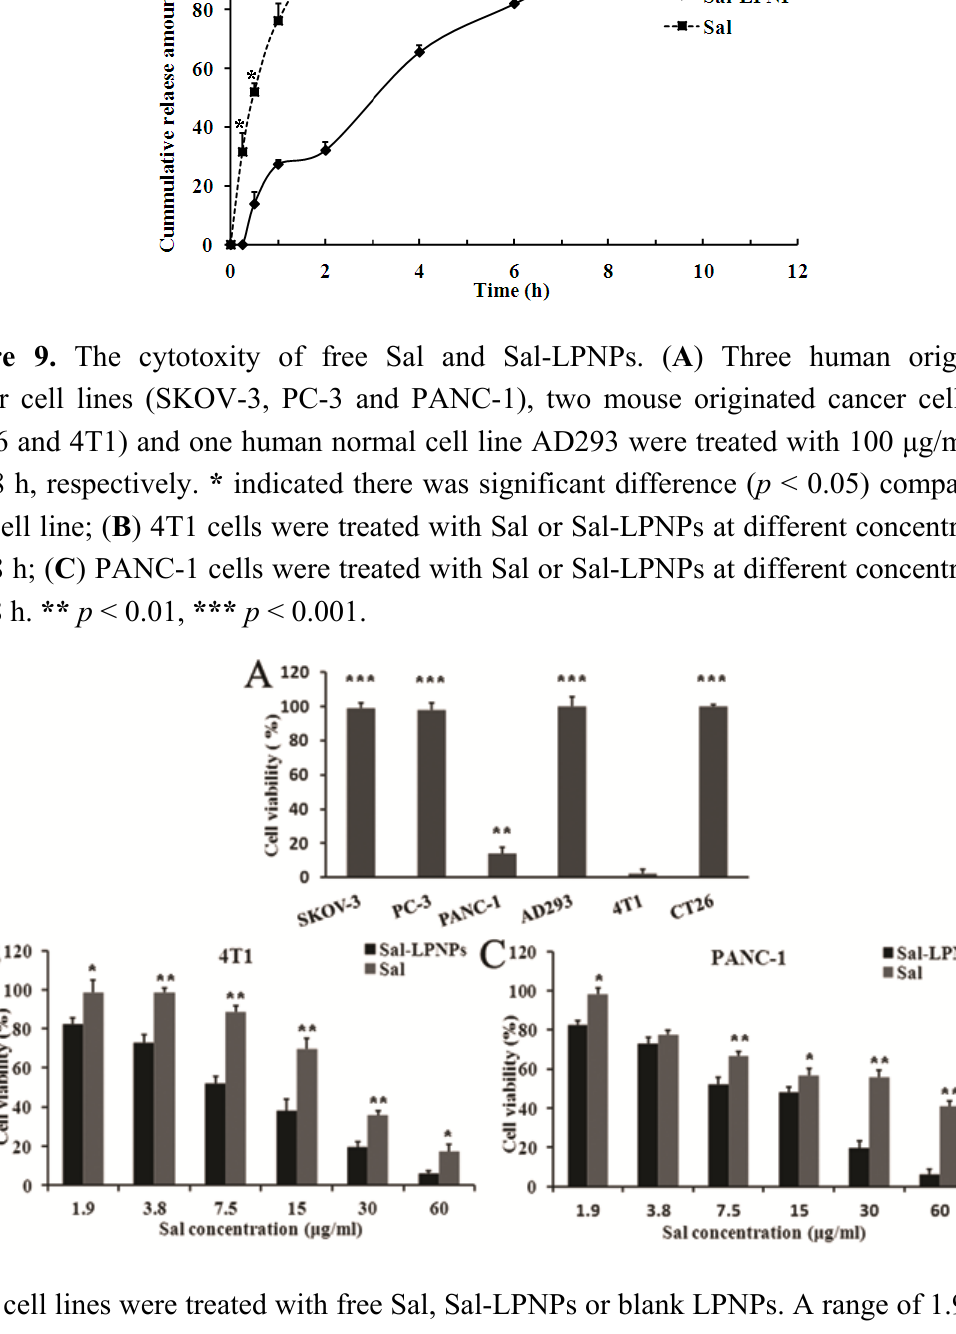
The two cell lines were treated with free Sal, Sal-LPNPs or blank LPNPs. A range of 1.9–60 μ g/mL Sal and corresponding amount of PLGA-PEG-PLGA copolymer and blank LPNPs were investigated. Blank LPNPs had no effect on cell growth for all the tested concentrations (data not shown). Free Sal and Sal-LPNPs inhibited the cell growth in a dose-dependent manner. Compared with free Sal